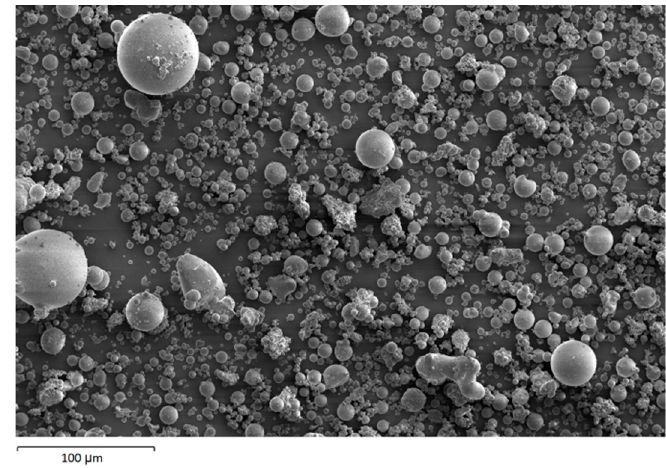
Figure 5. Morphology of fly ash.